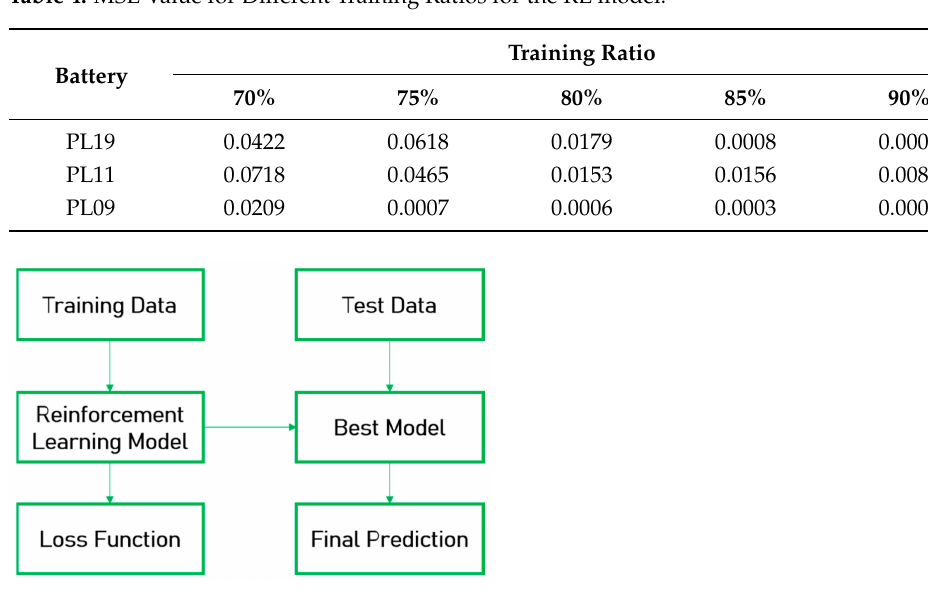
Figure 18. Finding the best Train–Test Split.